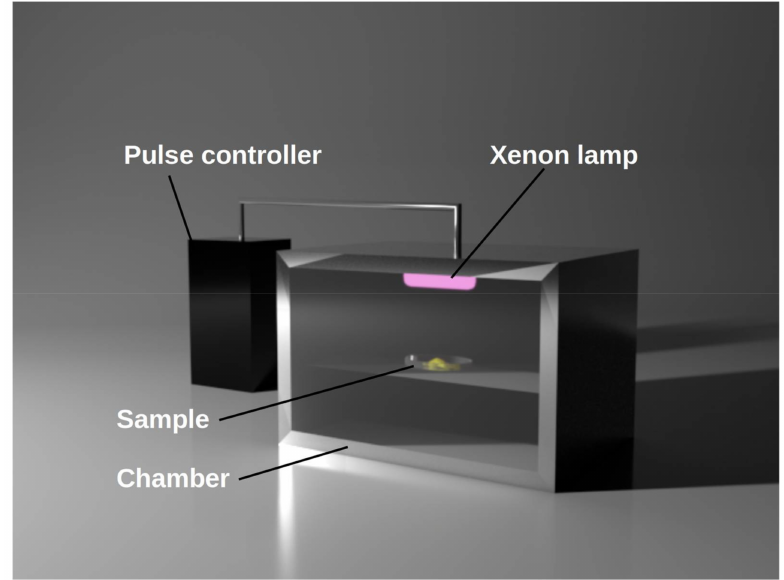
Figure 6. A schematic of pulsed light